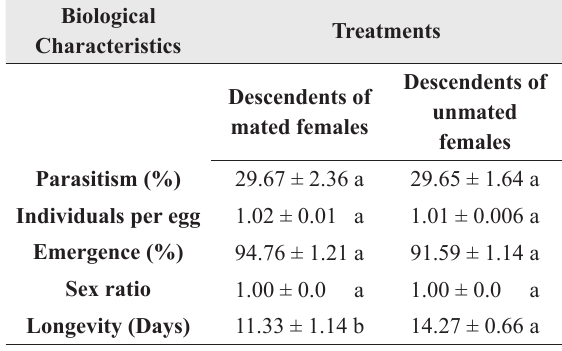
Interference of mating on the biological characteristic of the offspring population of Trichogramma pretiosum (Hymenoptera: Trichogrammatidae), obtained in